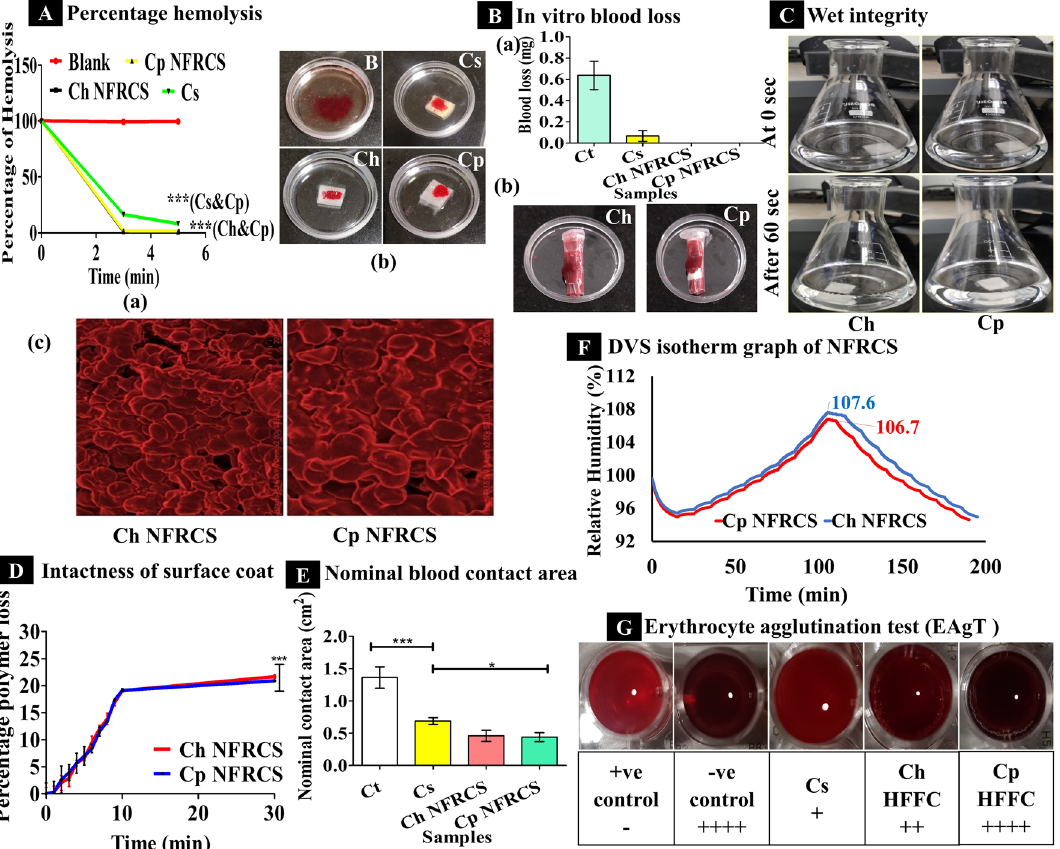
Figure 3. The above image represents the in vitro evaluation of Ch NFRCS, Cp NFRCS, and Cs. ( A ) a) Graphical representation of percentage hemolysis of RBC in the presence of Ch NFRCS, Cp NFRCS, and Cs, (n = 3); b). Images captured during the hemolysis assay; c). Represent the FESEM images captured from the surface of blood-treated Cp NFRCS and Ch NFRCS. ( B ) a) Amount of blood loss before blood coagulation in the presence of Ct, Ch NFRCS, Cp NFRCS, and Cs samples (n = 3), no blood loss was observed for Ch NFRCS and Cp NFRCS; b) The digital images captured during the study of Ch NFRCS and Cp NFRCS samples in vitro blood coagulation before blood loss. ( C ) The above digital images represent the wet integrity of Ch NFRCS and Cp NFRCS at 0 s and 60 s (n = 3). ( D ) Graphical representation of intactness of the surface coat when exposed to external stimuli (sonic waves) (n = 3). ( E ) Graphical representation of NBCA of test samples (n = 3). ( F ) The above image represents the DVS isotherm of Ch NFRCs and Cp NFRCS samples (hygroscopic). ( G ) The image represents the Erythrocytes agglomeration in the presence of Cs, Ct, Ch HFFC, and Cp HFFC samples (Cp HFFC showed the best EAgT compared to other samples). Data in A, B, D, and E images is represented as mean ± SD, n = 3, with *** p <